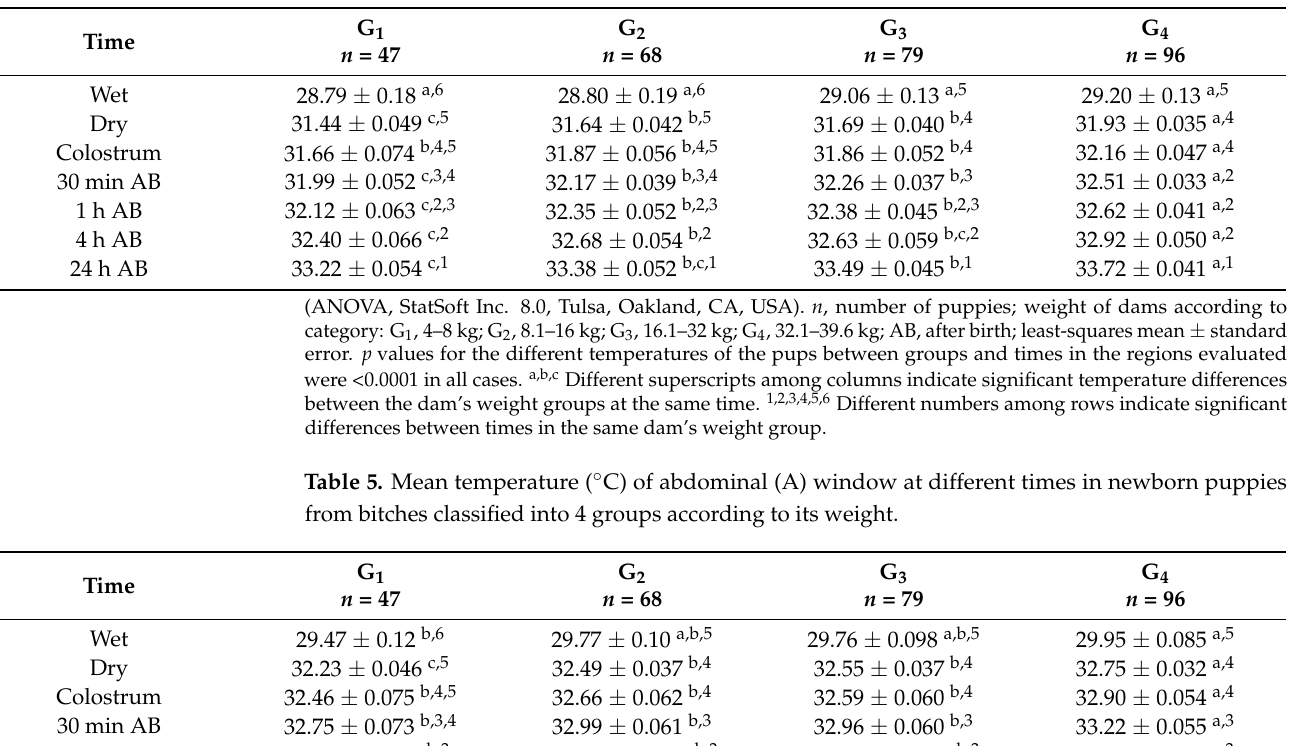
Table 4. Mean temperature ( ◦ C) of thoracic (T) window at different times in newborn puppies from bitches classified into 4 groups according to its weight.